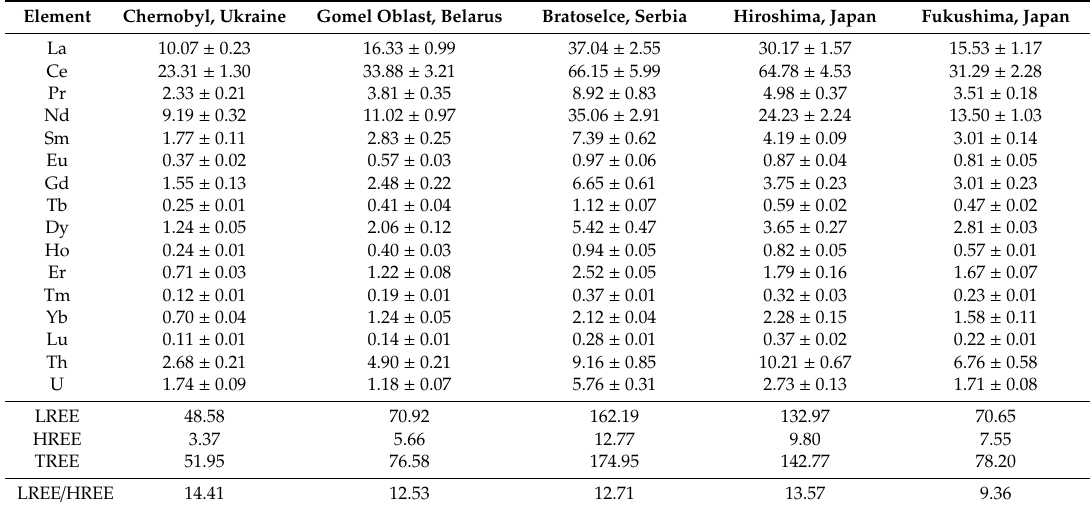
Table 2. Concentration ( ± SD) of REEs, Th and U in ( µ g / g) for di ff erent soils. (For, n = 5). Element Chernobyl, Ukraine Gomel Oblast, Belarus Bratoselce, Serbia Hiroshima, Japan Fukushima,